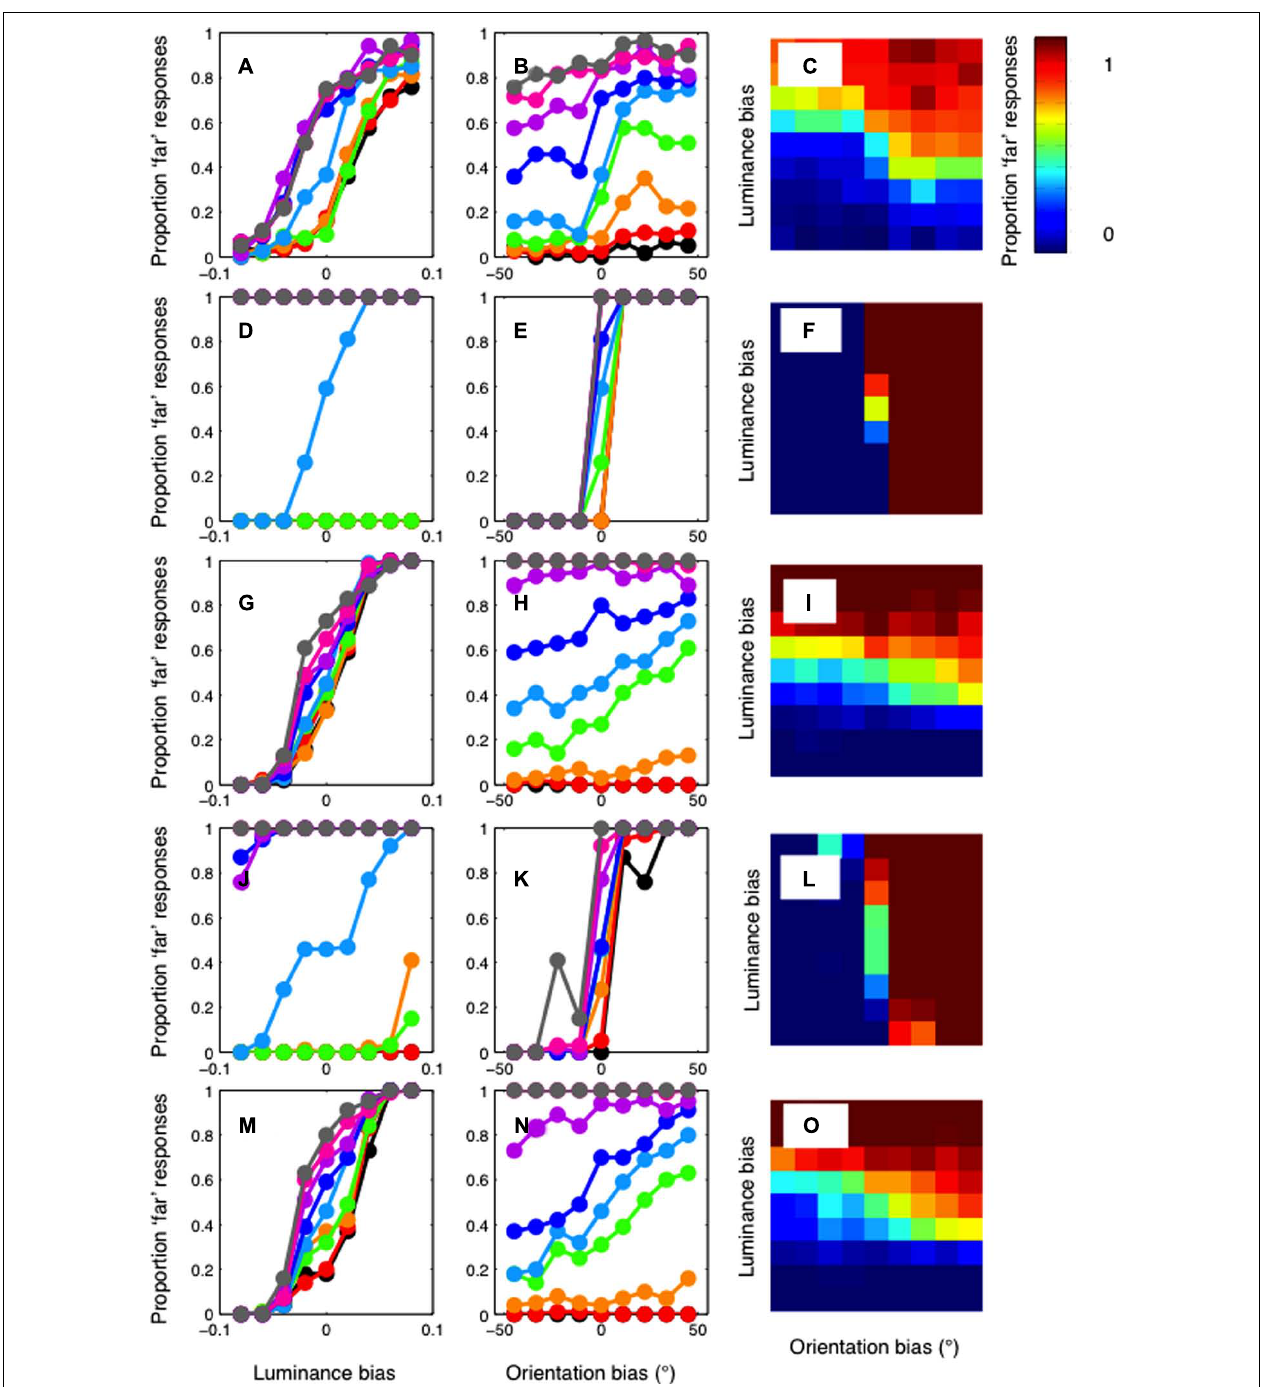
row (G–I) : The results of a cross-correlation model after filtering at a low spatial frequency (0.47 cpd). The model now shows a strong effect of luminance bias, and a weaker effect of orientation bias. Fourth row (J–L) : The results of a cross-correlation model after filtering at a high spatial frequency (3.79 cpd). This model shows a strong effect of orientation and a weaker effect of luminance. Fifth row (M–O) : The correlation model with filtering at 1.4 cpd shows the closest fit to the psychophysical